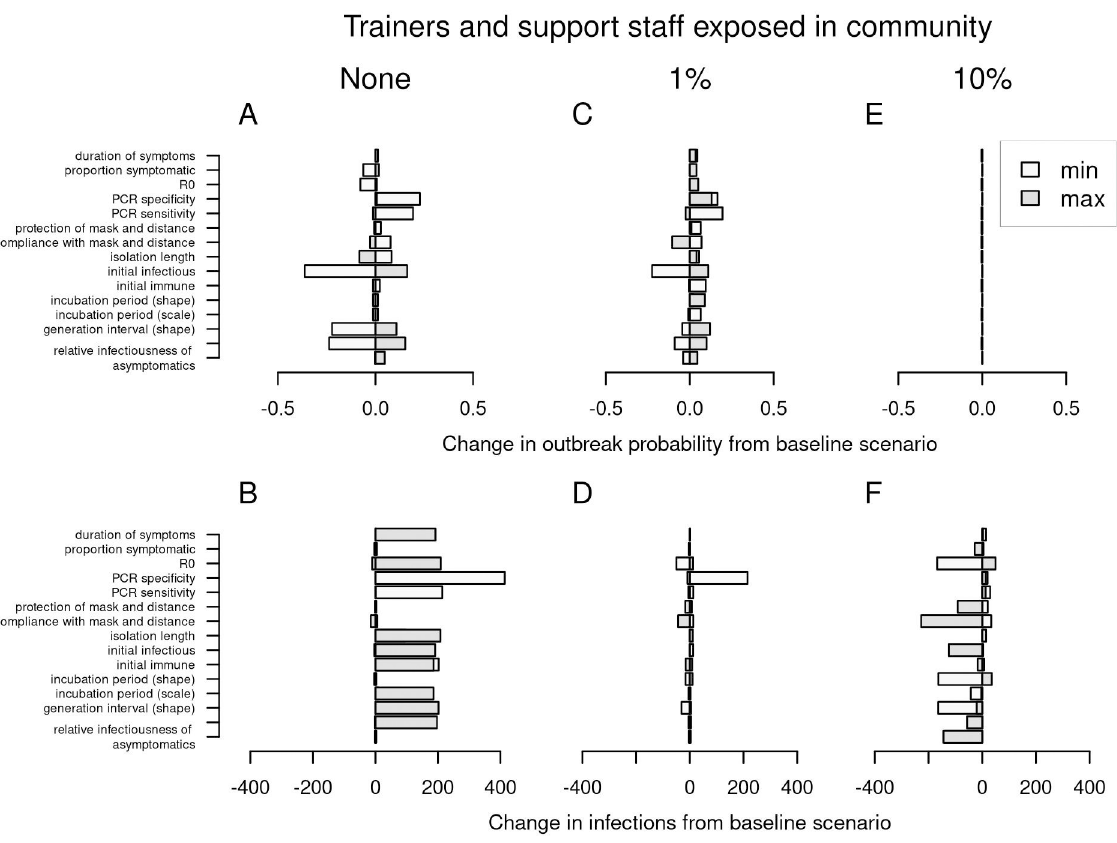
Fig 8. Univariate sensitivity analysis. Changes in outbreak probability (top) and outbreak size (bottom) relative to the baseline scenario are shown by the width of each bar. From left to right, columns show increases from 0 to 0.01 to 0.10 of the probability that trainers and support staff were exposed to the virus in the community over the course of the 70-day training